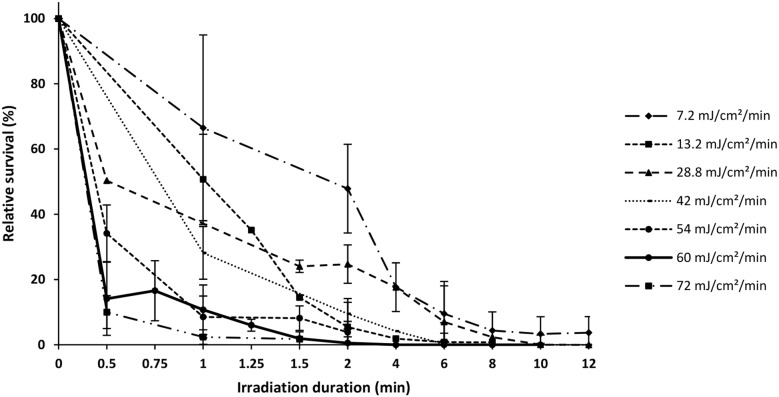
Percent survival relative to controls of hatched larvae issued from the different UV-irradiation treatments (7.2–72 mJ.cm−2.min−1) lasting 0.5–12 min.Error bars represent standard deviations of means (STD).